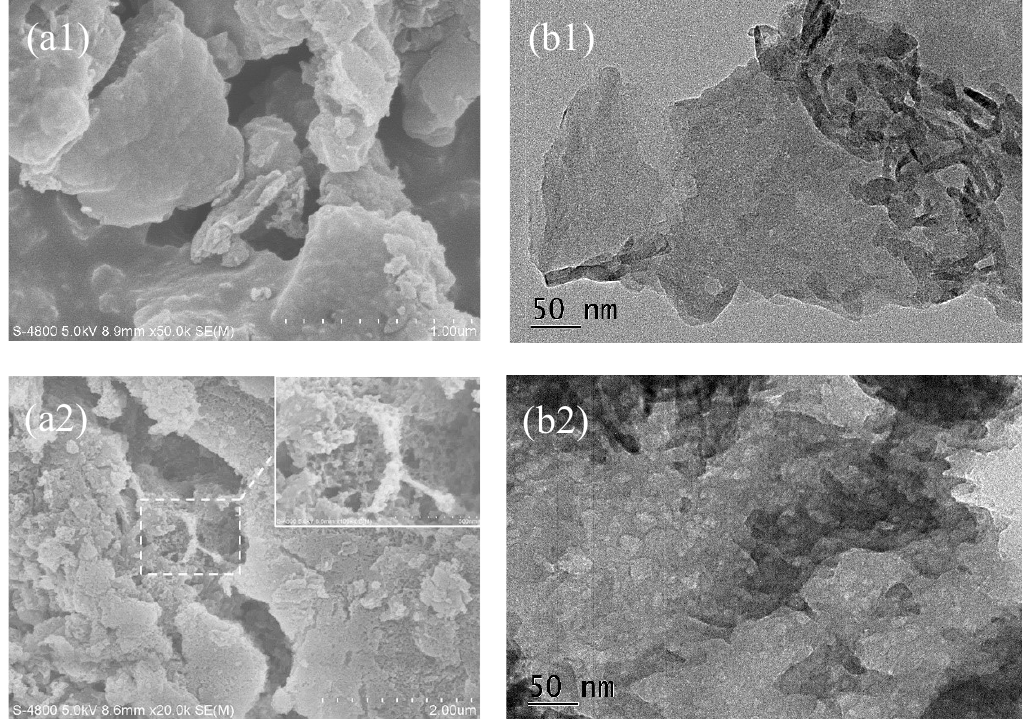
Figure 3. SEM ( a ); micrographs of pure CN ( a1 ); and B2-CN ( a2 ); TEM ( b ); micrographs of CN ( b1 ); and B2-CN ( b2 ).